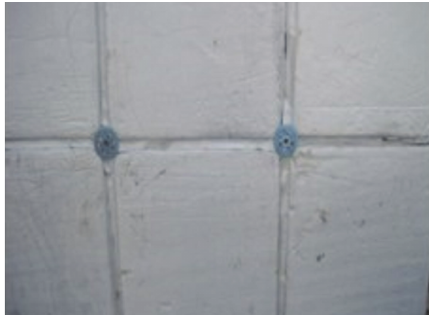
Figure 16: Actual images of VIP anchored by insulation